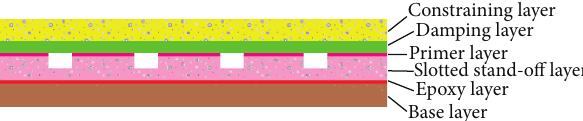
Figure 5: Schematic diagram of slotted stand-off layer damping